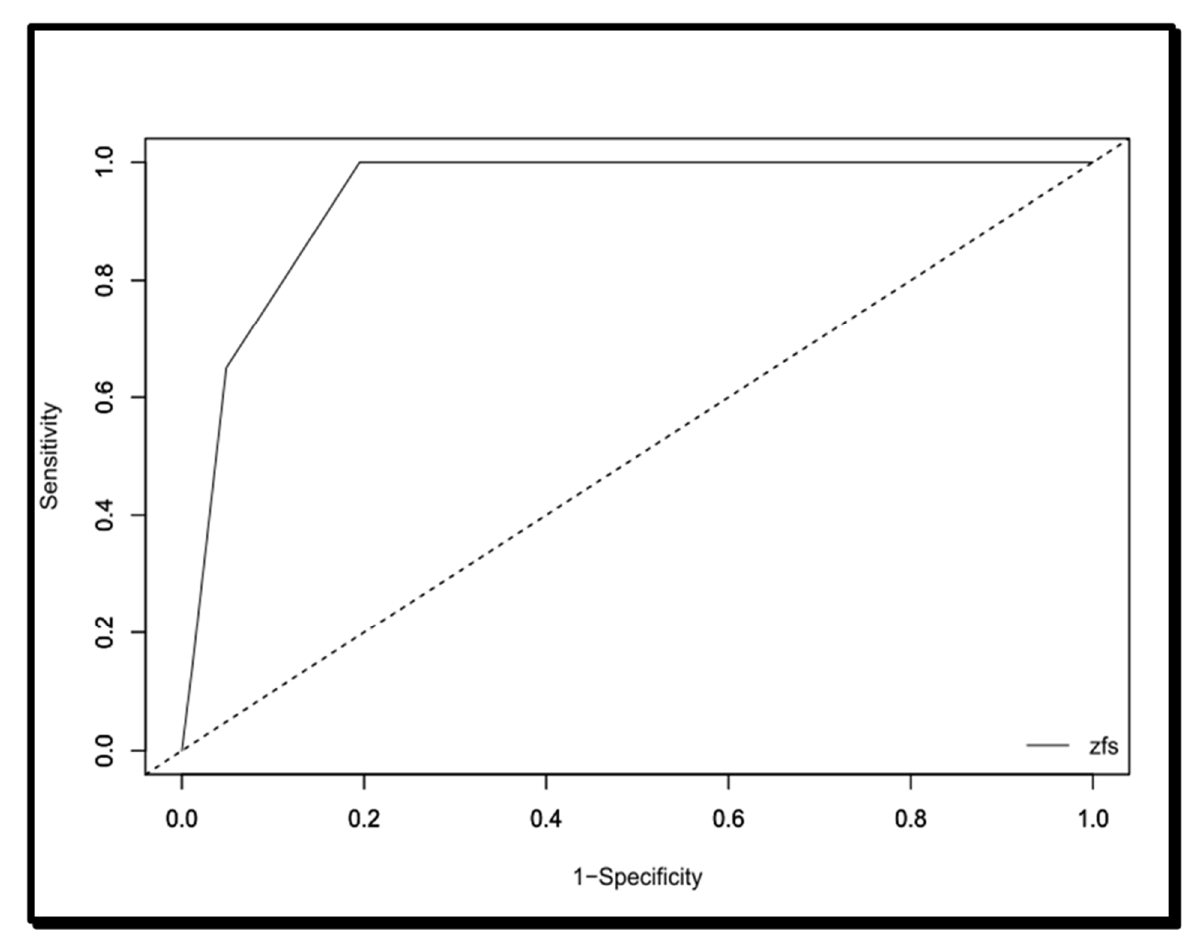
Figure 1. ROC curve of the Zulfiqar Frailty Scale. Table 9. Interpretation thresholds for the ROC curve.